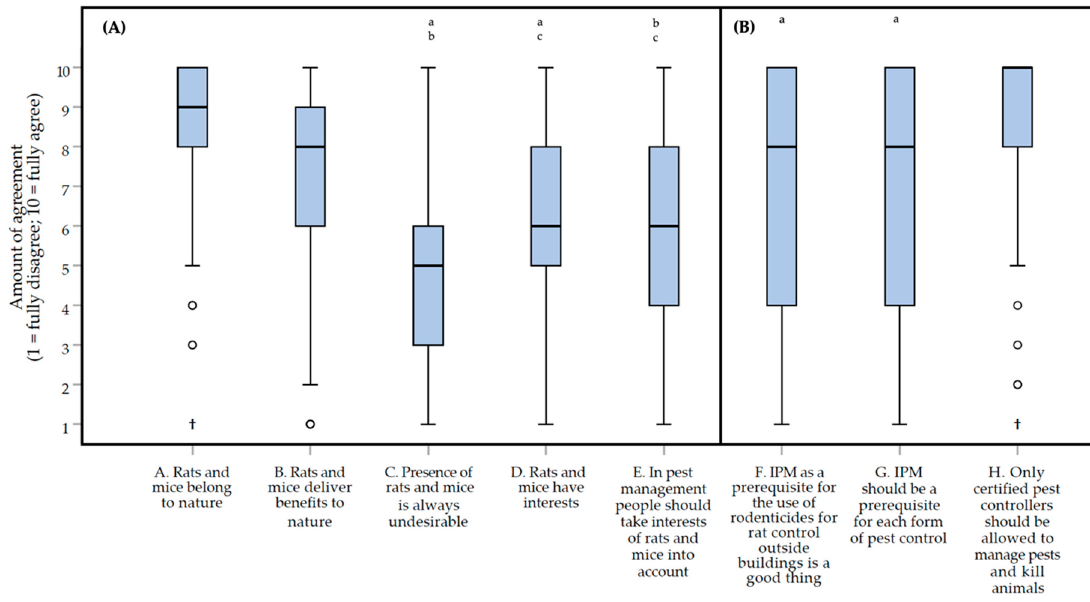
Figure 1. Box plots presenting the amount of agreement with statements about the general attitudes of rats ( Rattus rattus and Rattus norvegicus ) and mice ( Mus musculus ) (panel ( A ), statements A–E) and IPM (Integrated Pest Management) regulations (panel ( B ), statements F–H). The amount of agreement could be indicated on a 1 (fully disagree) to 10 (fully agree) interval rating scale. Interests of rats and mice were defined as living, freedom, and welfare. Data were obtained through an online survey among 129 Dutch pest controllers. Outliers and extreme cases are indicated with o and †, respectively. Differences between two statements that are not statistically significant are indicated with lower case letters above the bars.